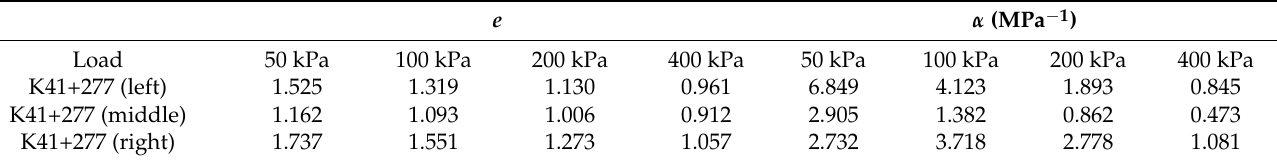
Table 5. Results of K41+277 consolidation tests for the expressway.